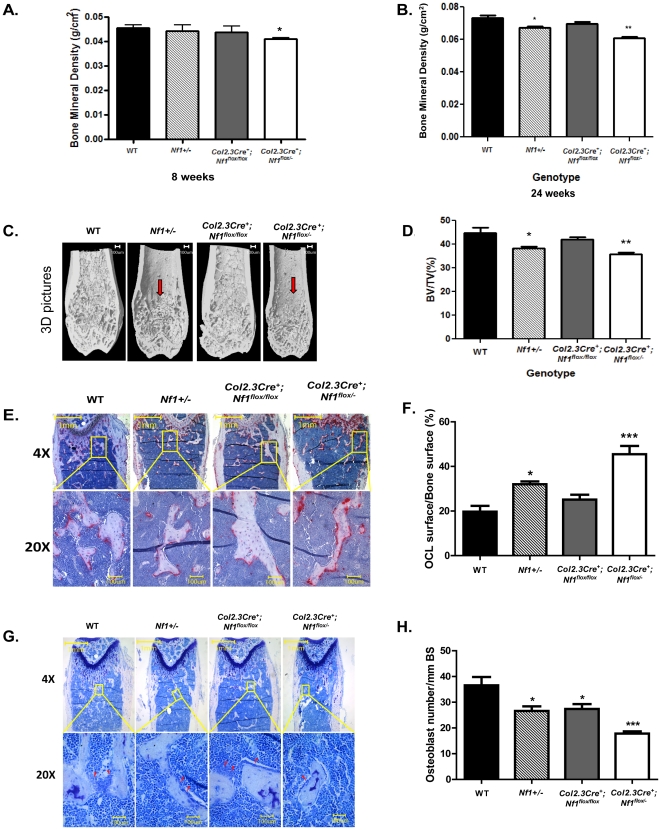
Loss of Nf1 results in reduced bone mineral density (BMD), volume (BV), and trabecular architecture in Col2.3Cre+;Nf1flox/− mice in vivo.BMD was measured with pDEXA scans at 8 weeks (A) (*p<0.05) and 24 weeks (B) (*p<0.05, **p<0.01). WT (n = 12), Nf1+/− (n = 10), Col2.3Cre+;Nf1flox/flox (n = 12), and Col2.3Cre+;Nf1flox/− (n = 11). (C) Micro-CT (μCT) scans were performed on the distal femurs of 4 month old WT (n = 5), Nf1+/− (n = 5), Col2.3Cre+;Nf1flox/flox (n = 5) and Col2.3Cre+;Nf1flox/− (n = 5) mice. Representative reconstructed 3D pictures are shown. The anterior portion of each femur has been removed for the metaphyseal architecture analysis. Deficiencies in the trabecular network are indicated by the red arrows. (D) Quantitation of 3D reconstruction and BV/TV ratio analysis. Trabecular bone formation is decreased in both Nf1+/− (*p<0.05) and Col2.3Cre+;Nf1flox/− (**p<0.01) mice as compared to WT and Col2.3Cre+;Nf1flox/flox mice. Four month old WT (n = 5), Nf1+/− (n = 5), Col2.3Cre+;Nf1flox/flox (n = 5), and Col2.3Cre+; Nf1flox/− (n = 5) mouse femur samples were processed for analysis. TRACP staining (E, F) and MacNeals' staining (G, H) were performed. (E) Representative photographs of the trabecular bone following TRACP staining (upper panel 4× and lower panel 20×) are shown. The red stained area indicates osteoclasts. (F) Quantitative analysis showing the change of osteoclast surface per bone surface. ***p<0.0001 as analyzed by ANOVA and Bonferroni's Multiple Comparison Test. (G) Representative photomicrographs (upper panel 4× and lower panel 20×) are shown. Light pink staining represents bony tissue (trabecular spicules). Blue staining represents the marrow cavity and includes bone marrow cells. Red arrow head are pointing to osteoblasts. (H) Quantitative data of osteoblast number over bone surface. One-way ANOVA analysis and Bonferroni's Multiple Comparison Test were used to evaluate statistical significance of the results. ***p<0.0001.